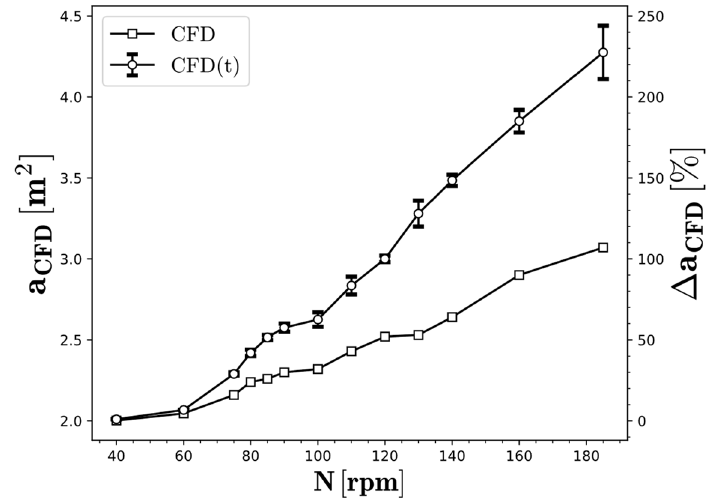
Figure 10. CFD mass transfer areas computed as a function of rotational speed. Squares represent areas obtained from mean fields, and dots represent areas obtained from time-averaging instantaneous fields over 1 s. The right axis represents the % increase in area with respect to a flat surface.